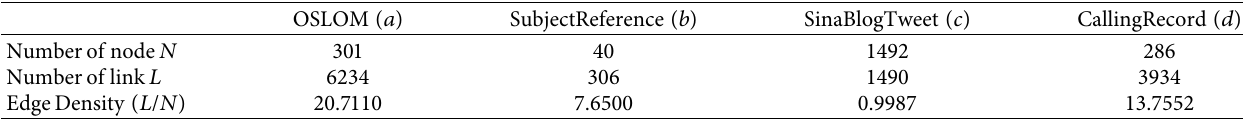
Table 3: Directed network dataset.